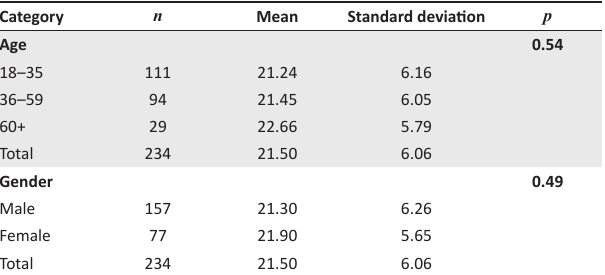
TABLE 5: Disability scores for physical impact of upper limb fractures ( n = 234). Category n Mean